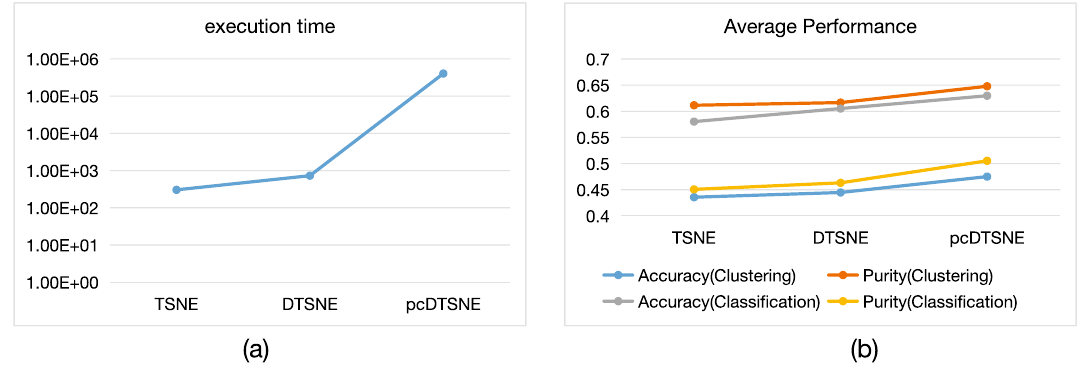
Fig. 2 a Average execution time of pcDTSNE on 12 datasets. b Average performance of the three models for clustering and classification of 12